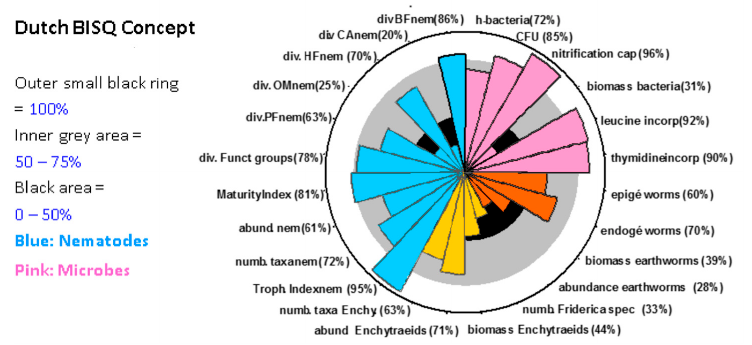
Figure 2. Results of a soil biological monitoring at a Dutch conventional farm in relation to reference data gained at an ecologically managed farm ([44], modified). Results for each organism group and endpoint (e.g., abundance, or biomass) are given in percent of the reference value for the same site type (100%, shown as outer black line). A difference of 25–50% (grey area) is classified as being of low and a difference of >50% as being of large concern. Abbreviations: abund = Abundance; BF = Bacterial-feeding nematodes; CAnem = Carnivorous nematodes; CFU = colony-forming units; div = diverse; Enchy = Enchytraeids; Funct = functional group; h-bacteria = Heterotrophic bacteria; HFnem = Hyphal-feeding nematodes; incorp = Incorporation; nem = Nematoda; numb = Number of species; OMnem = Omnivorous nematodes; PFnem = Plant-feeding nematodes; Spec = species; troph = trophic.